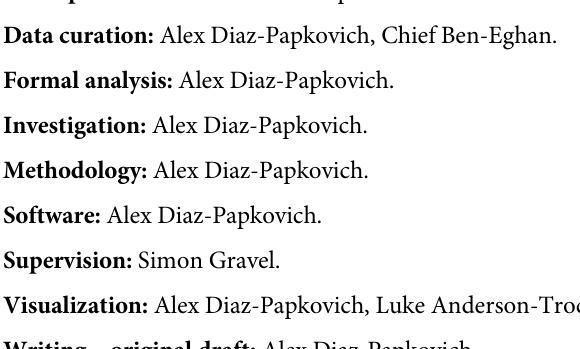
S1 Table. Variance explained by the PCs of the 1KGP. Variance explained in the 1KGP data by the number of principal components